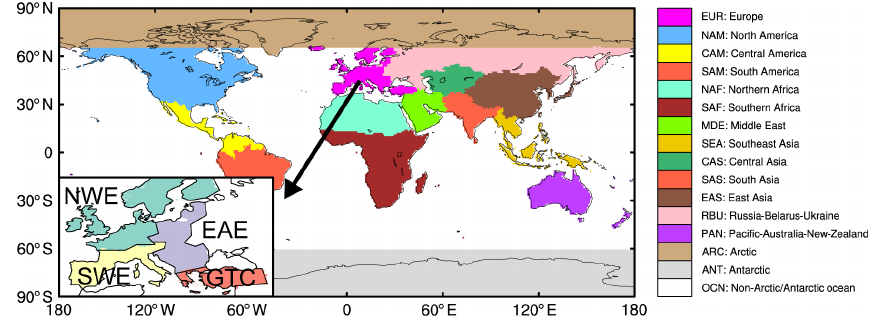
Figure 1. Source regions that are selected for the Explicit Aerosol Source Tagging (EAST) in this study, including Europe (EUR), North America (NAM), Central America (CAM), South America (SAM), northern Africa (NAF), southern Africa (SAF), the Middle East (MDE), southeast Asia (SEA), central Asia (CAS), South Asia (SAS), East Asia (EAS), Russia–Belarus–Ukraine (RBU), Pacific–Australia–New Zealand (PAN), the Arctic (ARC), Antarctic (ANT), and non-Arctic/Antarctic ocean (OCN). The embedded panel (at bottom left) is Europe, as the receptor region, which is further divided to northwestern Europe (NWE), southwestern Europe (SWE), eastern Europe (EAE), and Greece–Turkey–Cyprus (GTC). Table 1. Annual emission (in teragrams per year), concentration (in micrograms per cubic meter), column burden (in milligrams per square meter), AOD (scaled up by a factor of 100), and DRF (in watts per square meter) of sulfate, BC, POA, SBP (sulfate-BC-POA), and SBP-SOA (sulfate-BC-POA-SOA) in Europe averaged over 1980–1984 and 2014–2018, as well as the differences between 1980–1984 and 2014–2018. Differences in percentage relative to mean values in 1980–1984 are presented in parentheses.